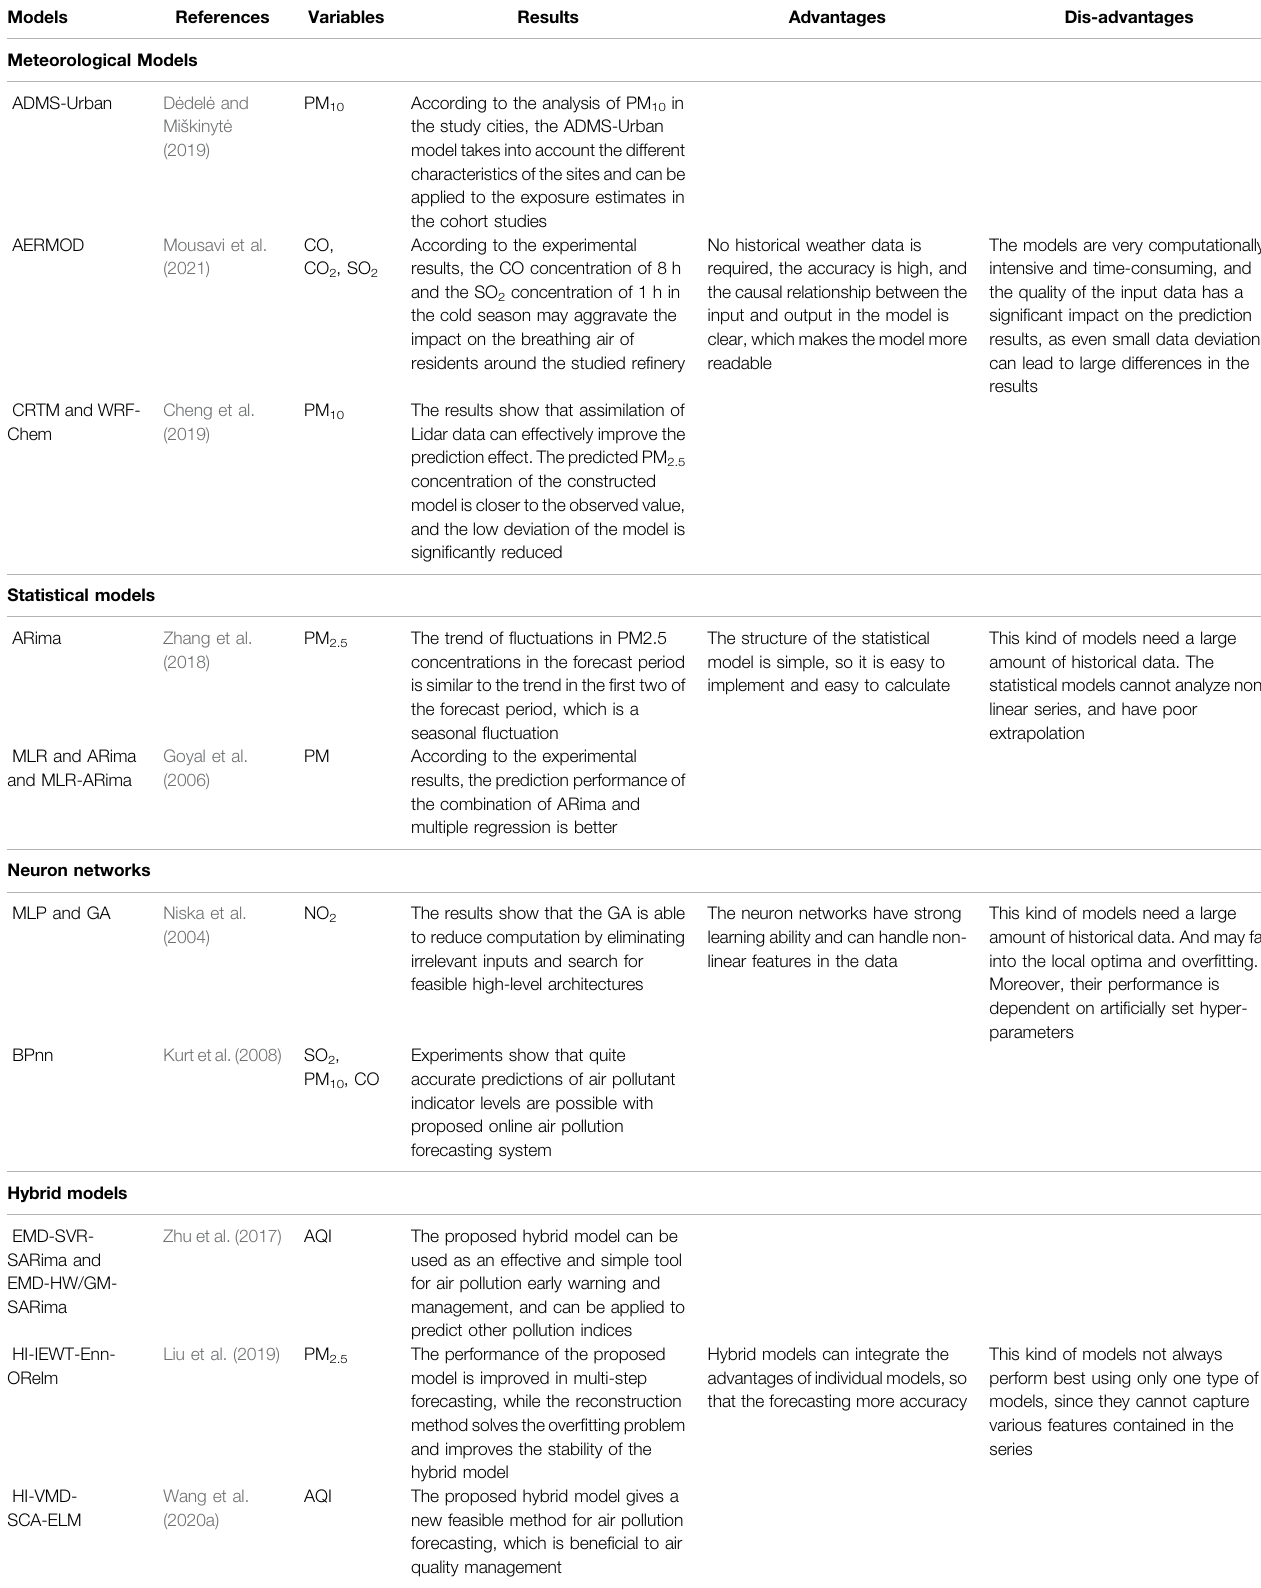
TABLE 1 | Summary of the different types of